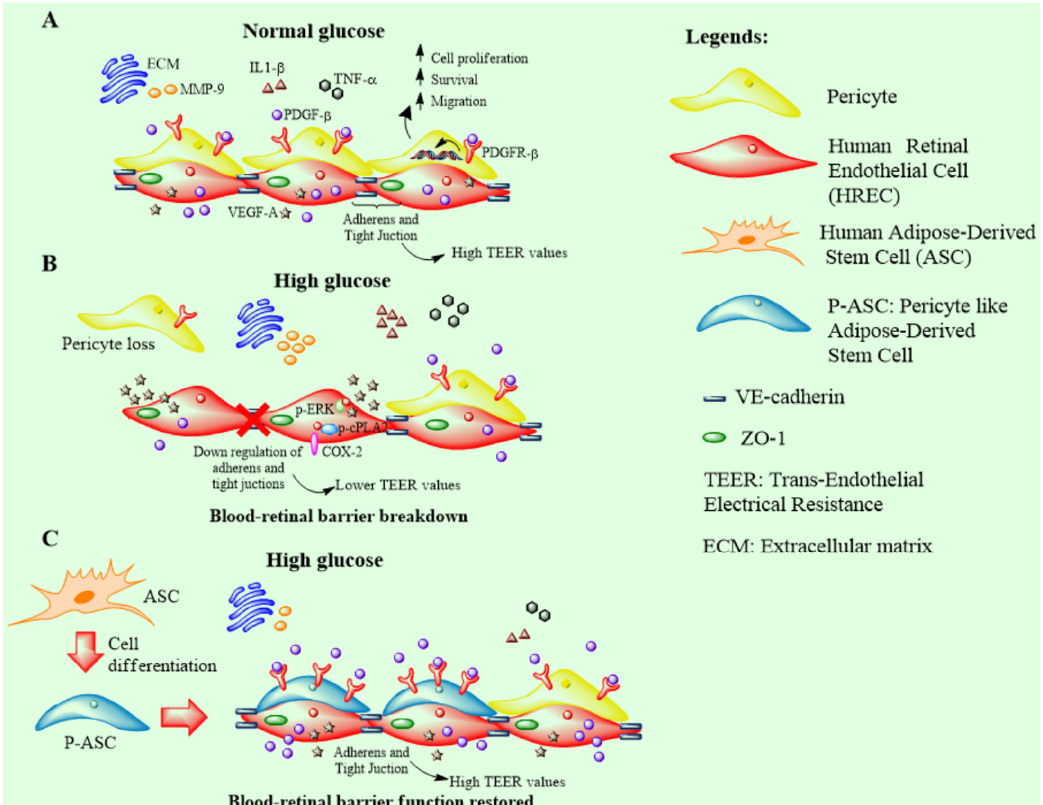
Figure 7. Schematic diagram of blood–retinal barrier (BRB) integrity restored (preserved) by the treatment with pericyte-like differentiated adipose-derived mesenchymal stem cells (P-ASCs) in the context of diabetic retinopathy. ( A ) In normal glucose conditions, human retinal endothelial cells (HRECs) tightly adhere to each other by both adherens (VE-cadherin) and tight junctions (zonula occludens-1; ZO-1), providing protection to retinal structures. The presence of cell junctions is responsible for high transendothelial electrical resistance (TEER) values, which are indicative of BRB integrity. In a health context, the release of inflammatory cytokines (i.e., interleukin-1 β (IL-1 β ) and tumor necrosis factor- α (TNF- α )), pro-angiogenic factor, vascular endothelial growth factor-A (VEGF-A), and matrix metalloproteinase-9 (MMP-9) is limited to satisfying homeostatic needs only. HRECs produce and release the platelet-derived growth factor- β (PDGF- β ), which is essential for the recruitment of pericytes to vessels. This molecule interacts with the platelet-derived growth factor receptor- β (PDGFR- β ), located on the pericyte surface, triggering an intracellular signaling cascade that ensures their survival, proliferation, and migration. ( B ) In diabetic retinopathy, high glucose concentrations cause BRB breakdown, characterized by a series of events involving endothelial cells, pericytes, and the extracellular environment. In HRECs, high glucose levels induce the activation of the p-ERK1/2/p-cPLA2/COX-2 axis associated with the inflammatory state. Moreover, the connections between endothelial cells become weaker because of the downregulation of both adherens and tight junctions. This condition, revealed by lower TEER values, makes the BRB more accessible to external insults. Endothelial cells also overexpress VEGF-A, which leads to increased angiogenesis correlated to inflammation. Furthermore, the excess of glucose causes a reduction in PDGF- β release from HRECs, and a concomitant decrease in PDGFR- β expression on pericytes. As a result, pericyte population density decreases, leaving endothelial cells unprotected. At the extracellular level, hyperglycemia provokes an inflammatory state supported by the release of IL-1 β and TNF- α , in addition to the increased release of MMP-9, responsible for the remodeling of the extracellular matrix. ( C ) Intraocular administration of P-ASC might result in beneficial effects, since these cells could act as substitutes for lost pericytes, thus limiting hyperglycemia-induced deleterious effects and possibly restoring BRB